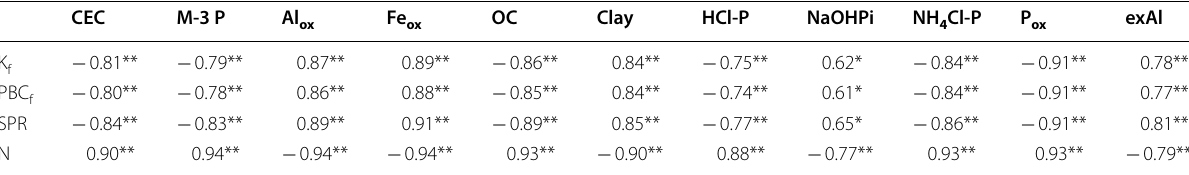
Table 4 Correlation table for Freundlich model coefficients and soil